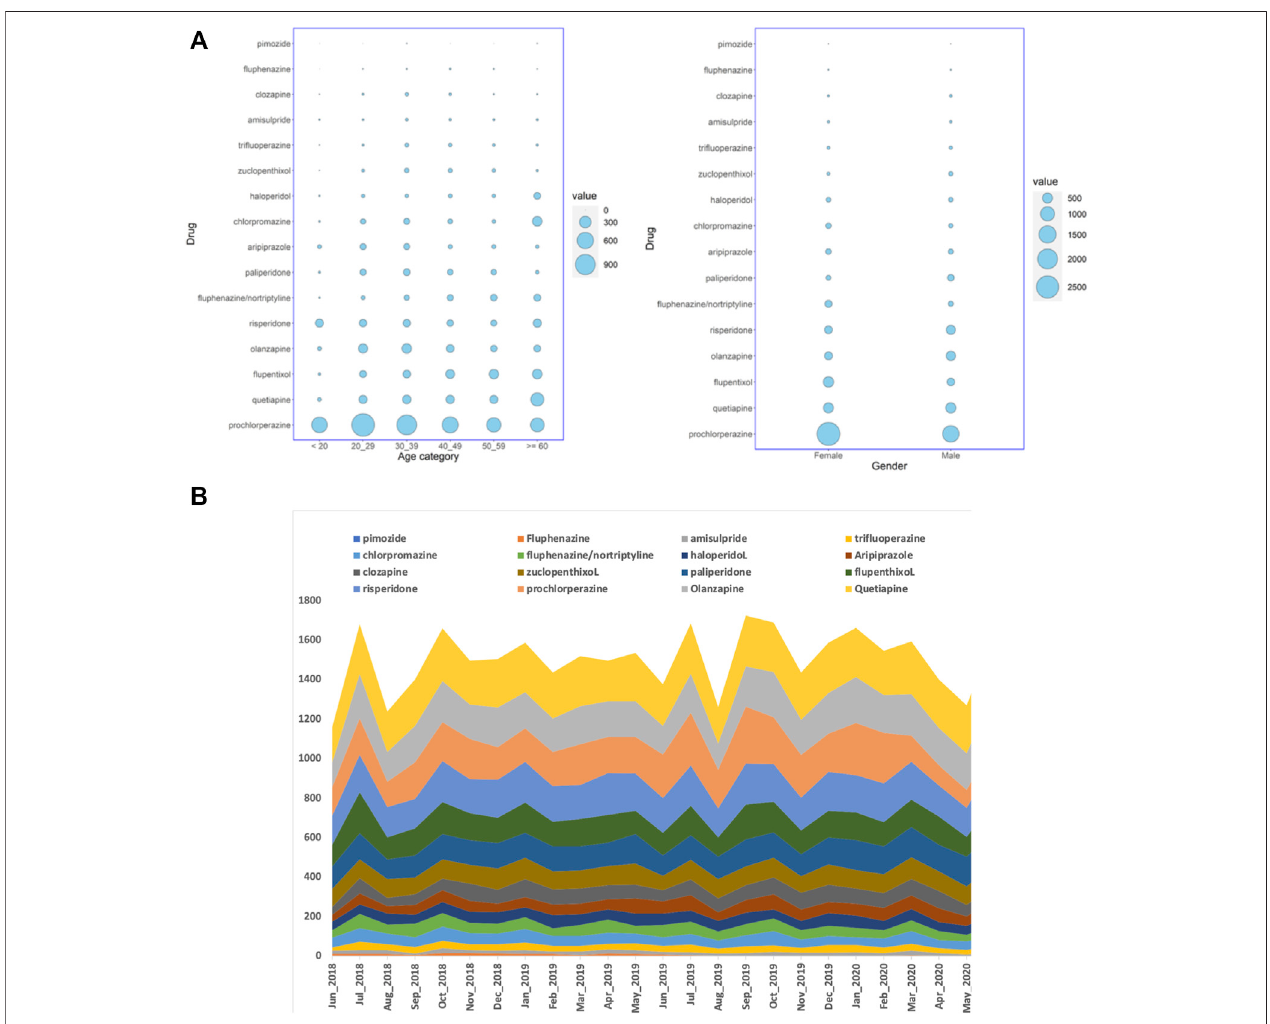
FIGURE 1 | (A) Balloon plots showing the distribution of the number of Qatari patients getting antipsychotic prescriptions over a period of 24 months in all the hospitals studied, strati fi ed by either age groups or gender, and (B) the number of dispensed antipsychotic prescriptions over the study period of 24 months in all the hospitals. The cumulative number of monthly dispensed prescriptions are shown on the Y-axis and the months on the X-axis.